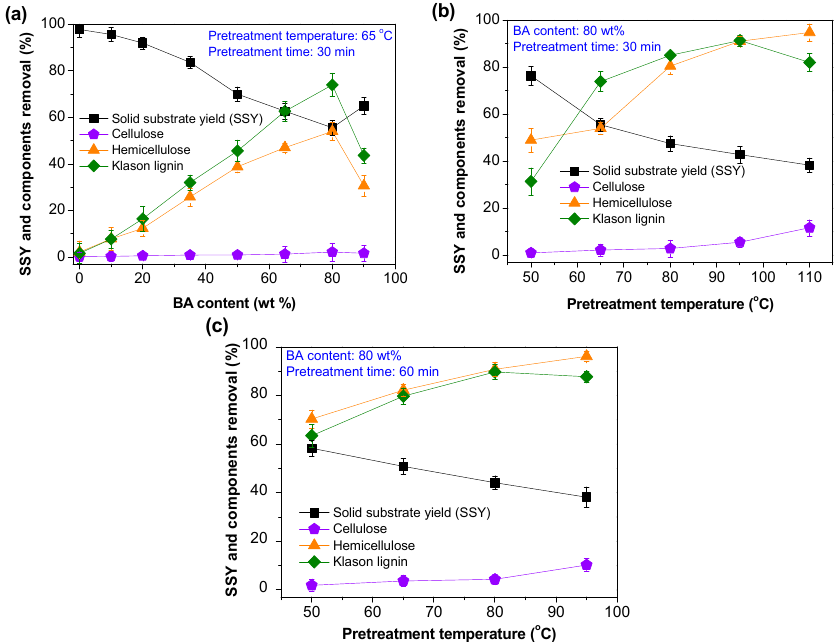
Figure 2. Effects of the pretreatment conditions on the solid substrate yield (SSY) and components removal. ( a ) BA content effects at 65 °C for 30 min; ( b , c ) temperature effects at a BA content of 80 wt % for ( b ) 30 min and ( c ) 60 min, respectively. Polymers 2020 , 12 , x FOR PEER REVIEW